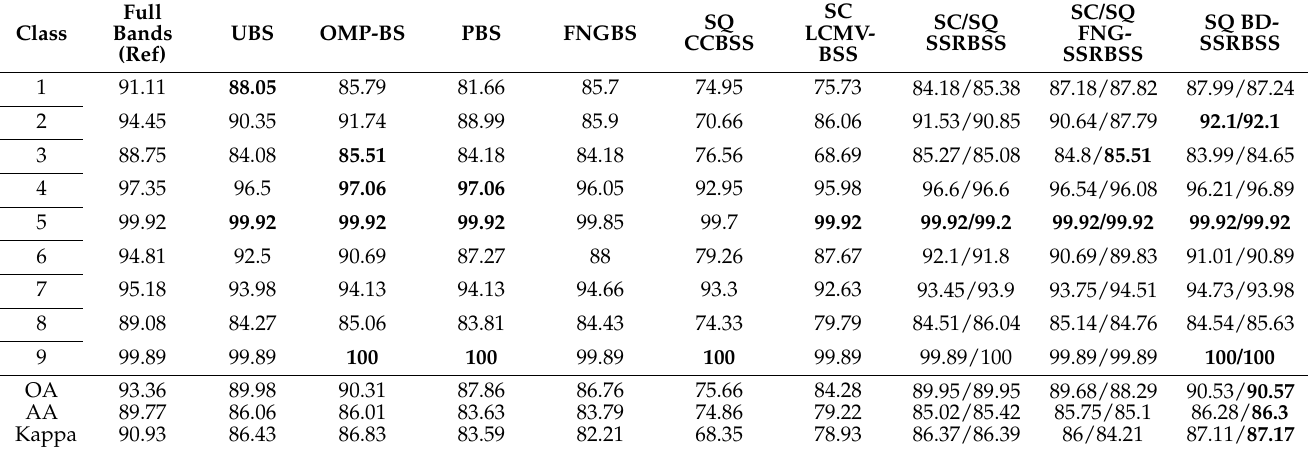
Table 6. SVM classification results of using the bands described in Table 3 for the Pavia dataset.